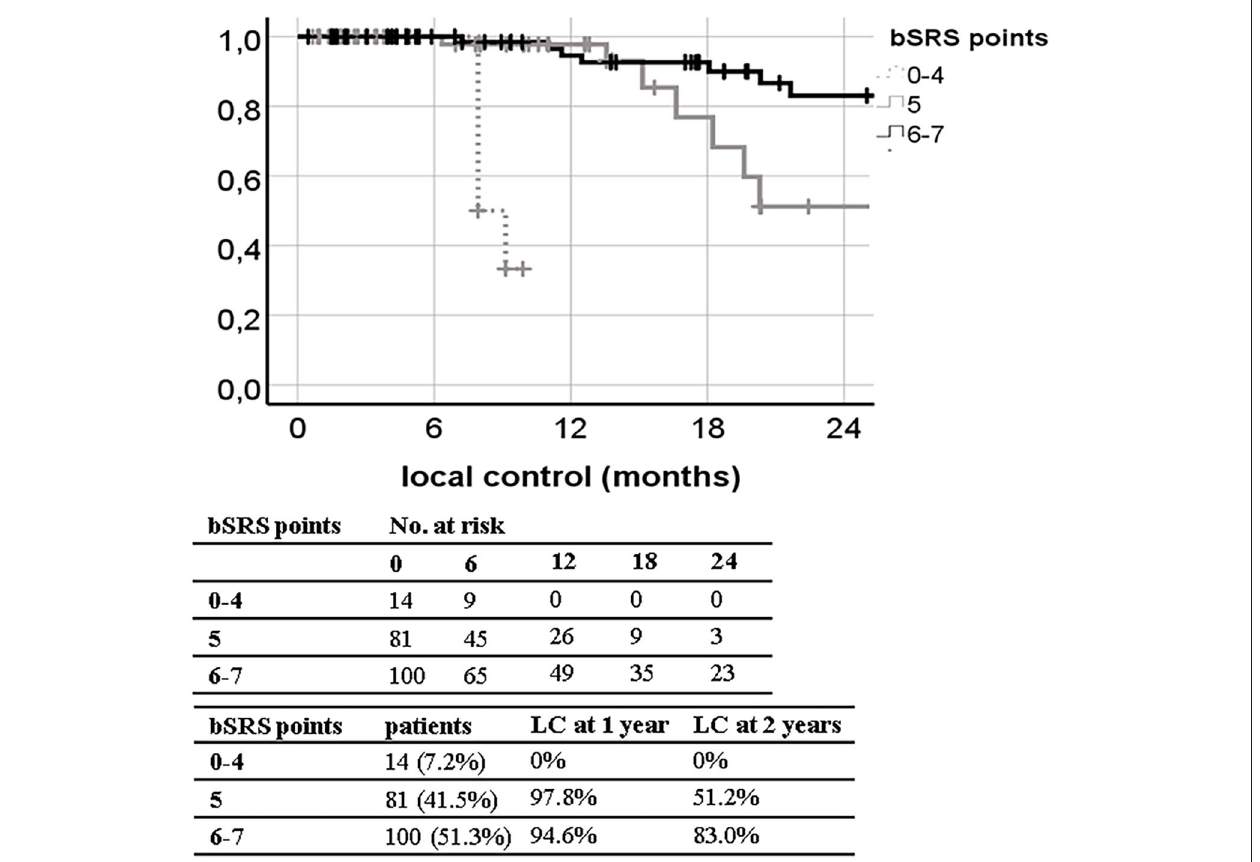
FIGURE 4 | Kaplan–Meier curves for local control (LC; n = 195) of the irradiated lesions ( n = 195) divided by the breast scoring tool for stereotactic therapy (bSRS) in our patient population (log-rank p < 0.001; concordance index 0.607; 95% CI, 0.462–0.751; p = 0.118) with 1- and 2-year LC